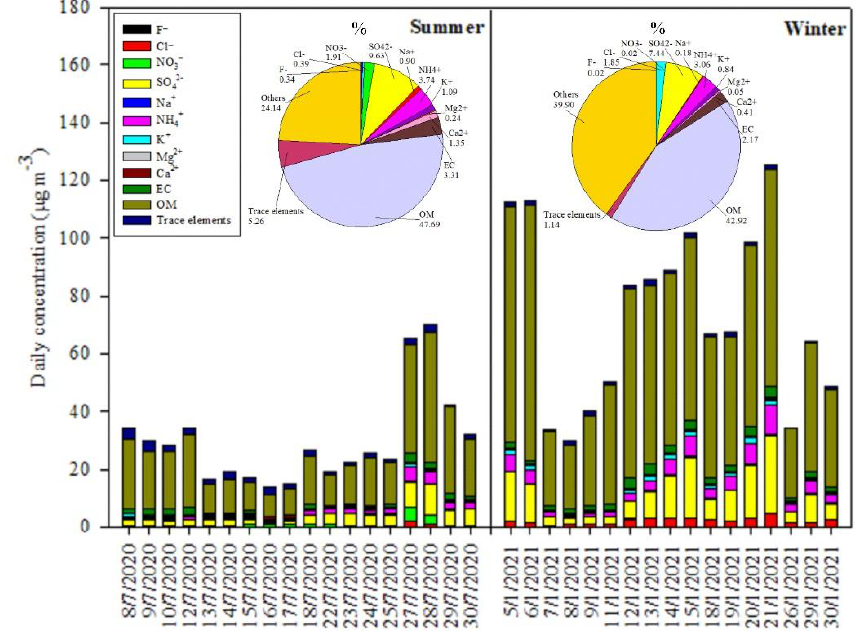
Figure 3. Daily PM 2.5 chemical composition measured at the sampling site for the summer and winter periods.